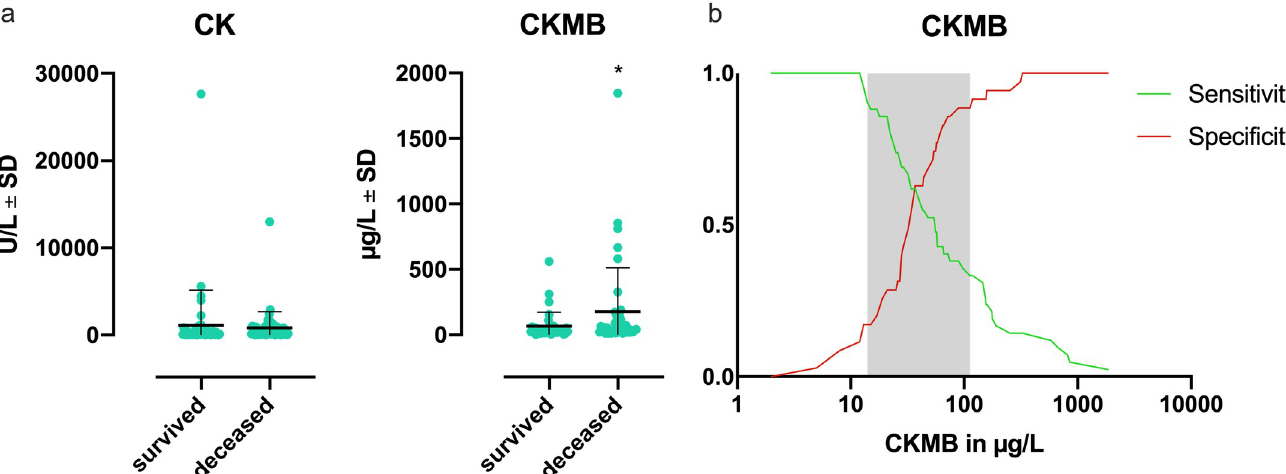
Fig 2. Patients who died of acute liver failure showed significantly higher CKMB values than those who survived. CKMB also has predictive value concerning mortality in ALF. (a) Creatine kinase (CK) and creatinine kinase-MB isoenzyme (CKMB) in relation to mortality. Patients who died in the course of acute liver failure (ALF) exhibited significantly higher CKMB values than survivors ( � p = 0.023, surviving n = 36, deceased n = 42). CK values showed no difference (p = 0.2, surviving n = 49, deceased n = 51). Shown are the means ± SDs, p < 0.05 was considered significant. (b) Plotted is the result of the receiver operating characteristic (ROC) analysis (AUC = 0.64, p = 0.006) as specificity and sensitivity versus CKMB values. CKMB > 112 μ g/L has a positive predictive value (PPV) of 66.7% and a negative predictive value (NPV) of